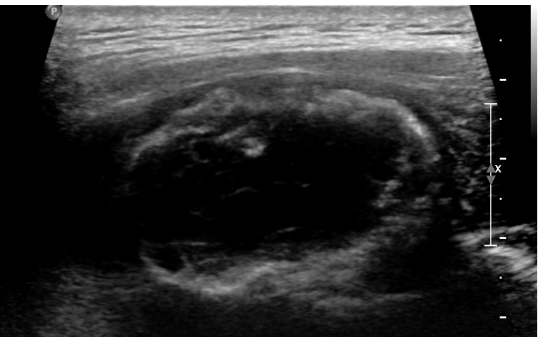
Figure 4. In the US, calcified peripheral rim and posterior shadowing were noted. A US-guided biopsy was performed.